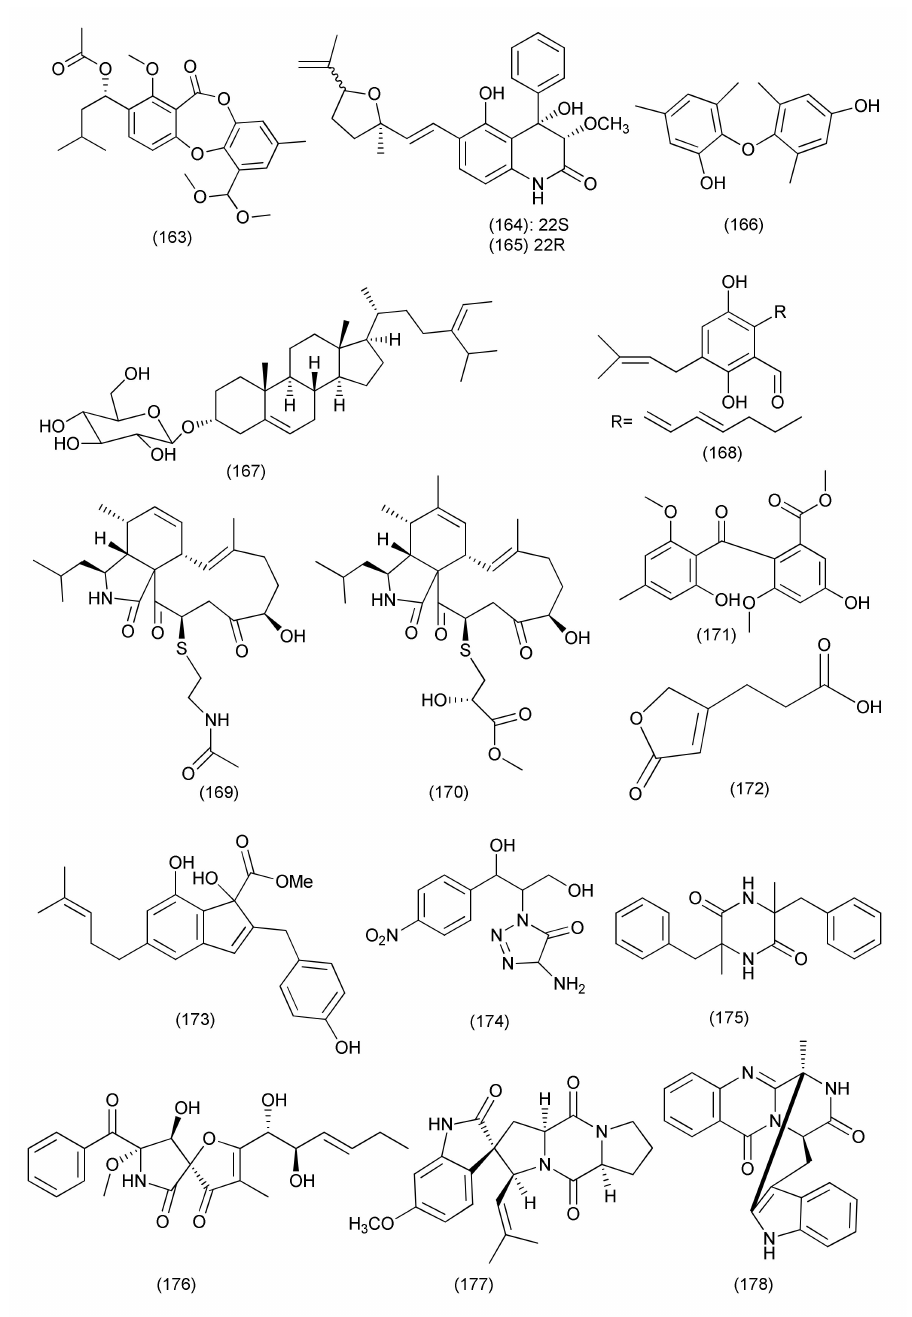
Figure 10. Structures of metabolites 163 – 178 isolated from Anamorphic